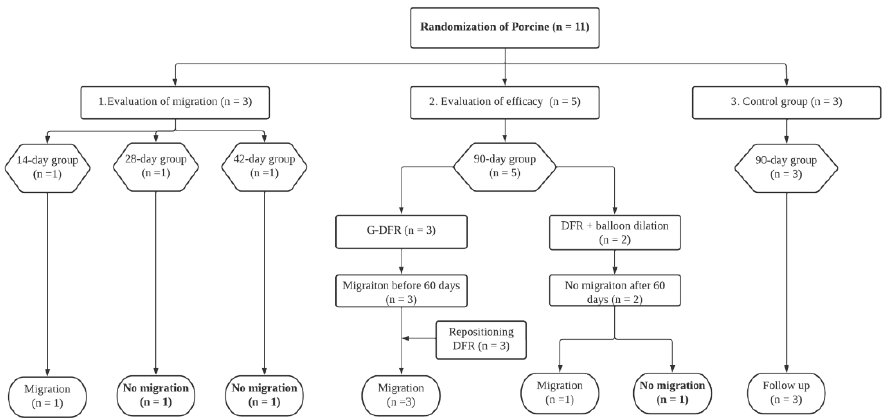
Figure 1. Flow diagram showing the steps of G-DFR placement. G-DFR, Gastro-duodenal flow re-